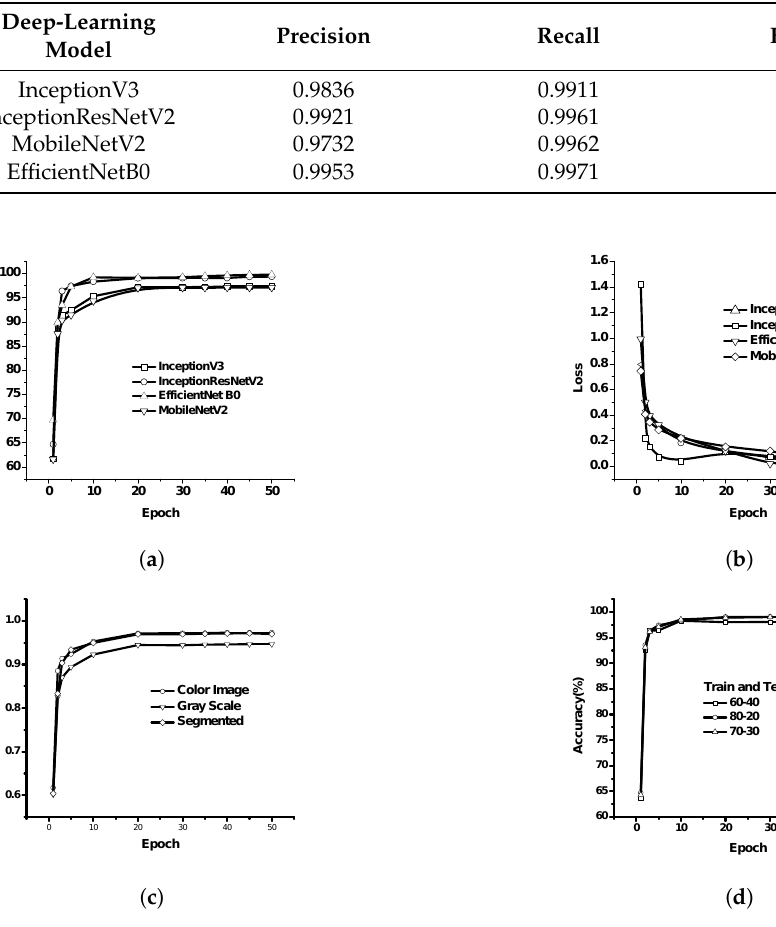
Figure 7. ( a ) Performance accuracy of implemented model. ( b ) Performance loss of implemented model. ( c ) F1 score of InceptionV3. ( d ) Accuracy of InceptionResNetV2 grouped by